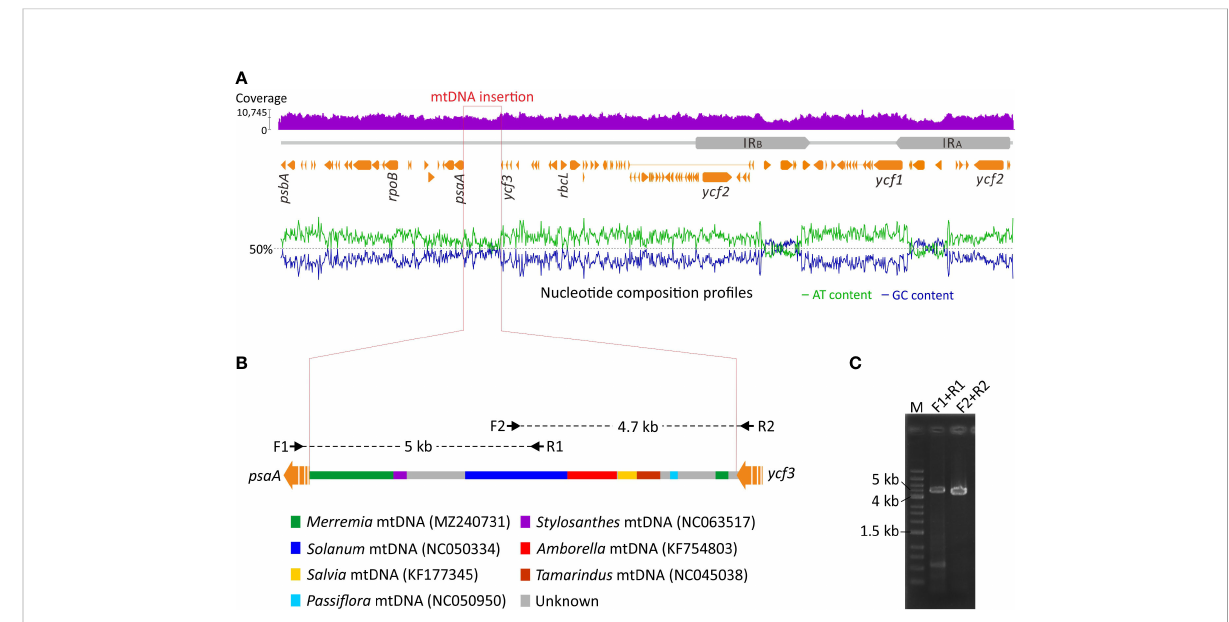
FIGURE 4 Schematic diagrams of PTMT integration in Jacquemontia . (A) Analyses of the DNA-seq read coverage and nucleotide composition across the whole plastome. (B) Blast results of the integrated PTMT showing a mixture of fragments best matching mtDNAs of some taxa with color codes given below. Black arrows are PCR primers designed in this study. (C) PCR veri fi cation of the integrated